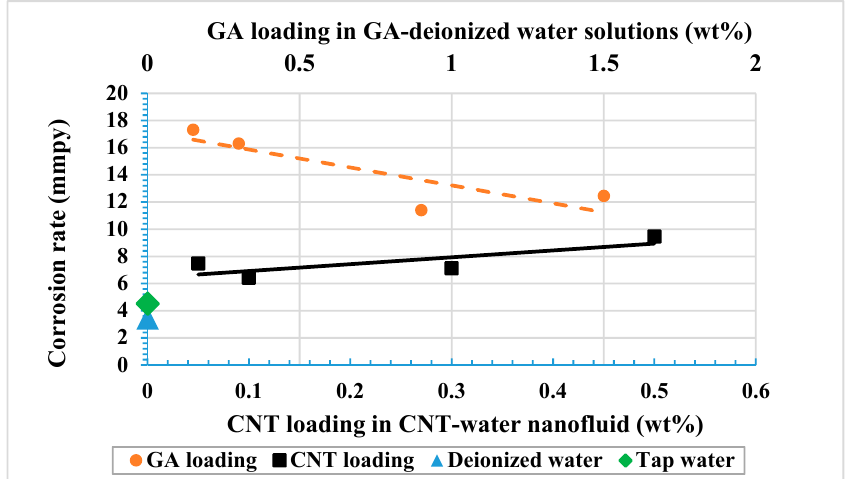
Figure 6. Corrosion rate for tested CNT-water nanofluids and for GA-water solutions. Table 6. Inhibition efficiency ( IE %) and surface coverage ( θ ) of 316L stainless steel samples tested in